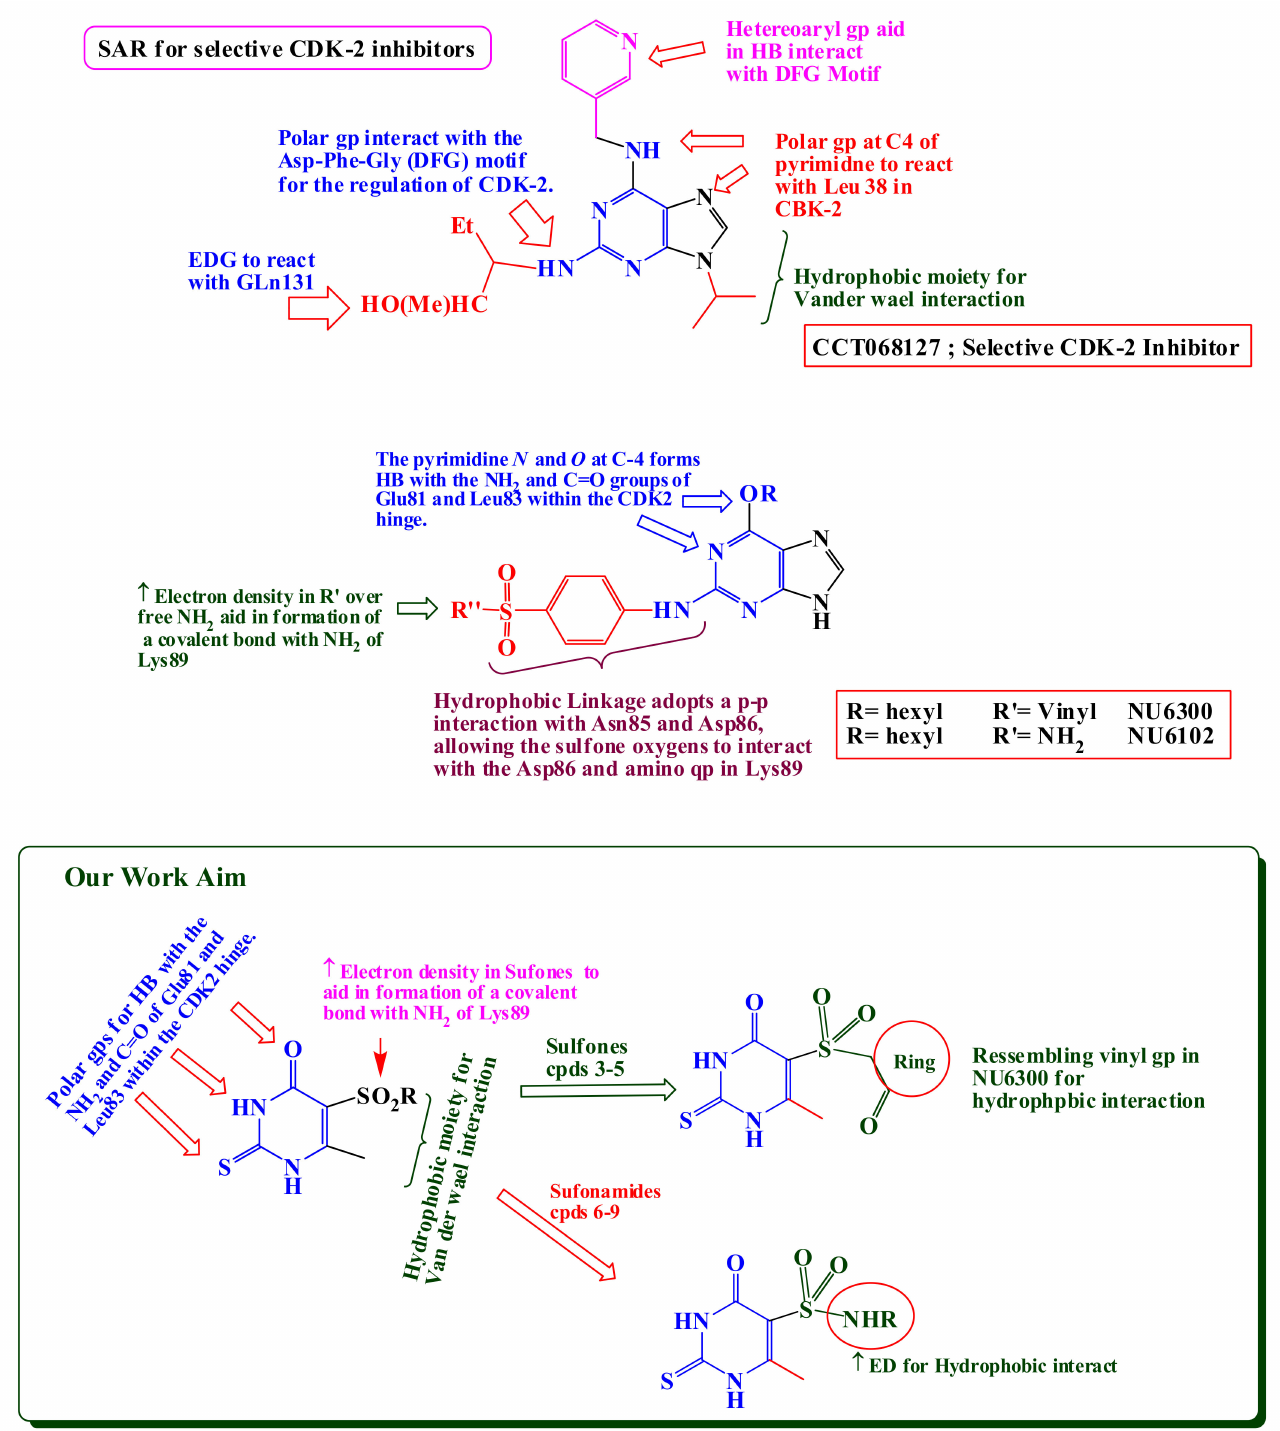
Figure 2. Structure-activity of some selected CDK-2 inhibitors [5–8,36,37] and structure design of our newly synthesized compounds 3 – 9